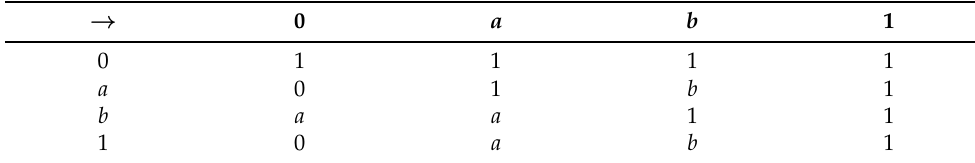
Table 6. The operation → .